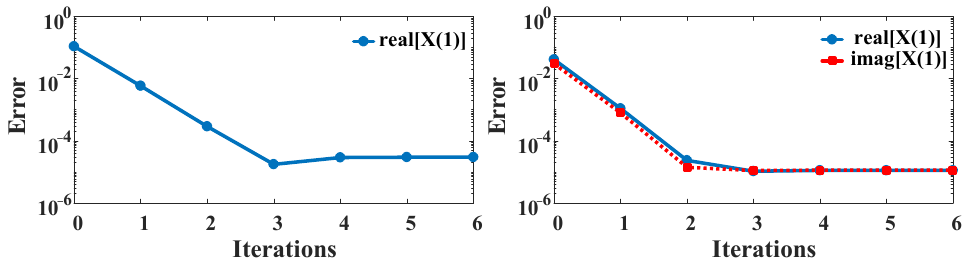
Figure 4. The estimation error of the main bin under different iterations. At the same time, the e-apDFT algorithm should only start iterative compensation when the DC component and the second harmonic component exist. Otherwise, it not only increases the computational complexity, but also reduces the estimation accuracy. Therefore, thresholds must be set to determine whether to initiate an iterative compensation. Here, we choose (cid:101) X ap ( 0 ) from (14) as the criterion of the iterative compensation of the DC